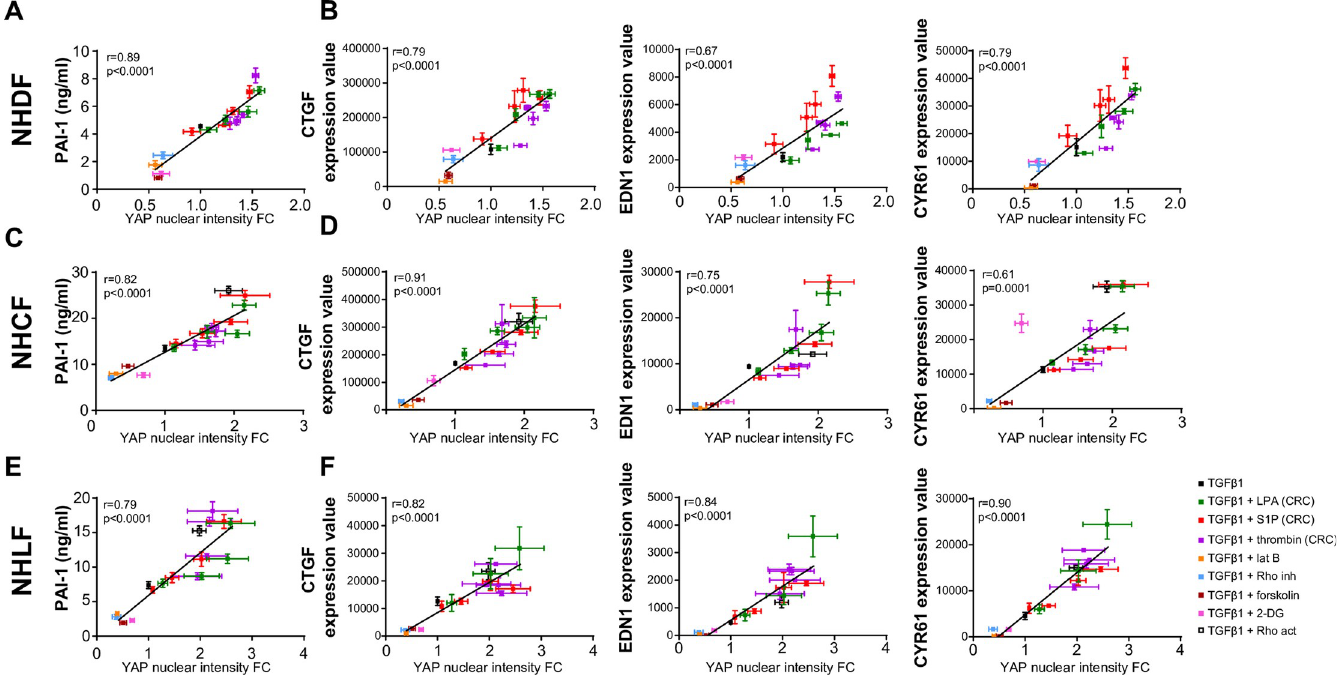
Fig 4. Response to TGF β 1 correlates with nuclear levels of YAP. (A-F) NHDF, NHCF and NHLF were starved and then treated with 5ng/ml TGF β 1 alone or in combination with indicated YAP modulators; concentration-response curve (CRC) of LPA and S1P (10-fold dilutions starting at 1 μ M), thrombin (10-fold dilutions starting at 1mU/ml), 500nM latrunculin B (lat B), 2ng/ml Rho inhibitor (inh), 10 μ M forskolin, 50mM 2-DG or 1ng/ml Rho activator (act). Integrated nuclear intensity of YAP was analysed after 1h by high content imaging analysis of cells stained against YAP and expressed as fold change (FC) versus TGF β 1-only treated cells. The same treatments were done for 3h to measure gene expression by RT-qPCR and for 24h to analyse PAI-1 in cell supernatants by ELISA. PAI-1 levels and gene expression were correlated (linear correlation) with YAP nuclear staining. (n = 3–4; YAP imaging). (n = 3; RT-qPCR). (n = 4–8; ELISA). Mean+/- SEM.